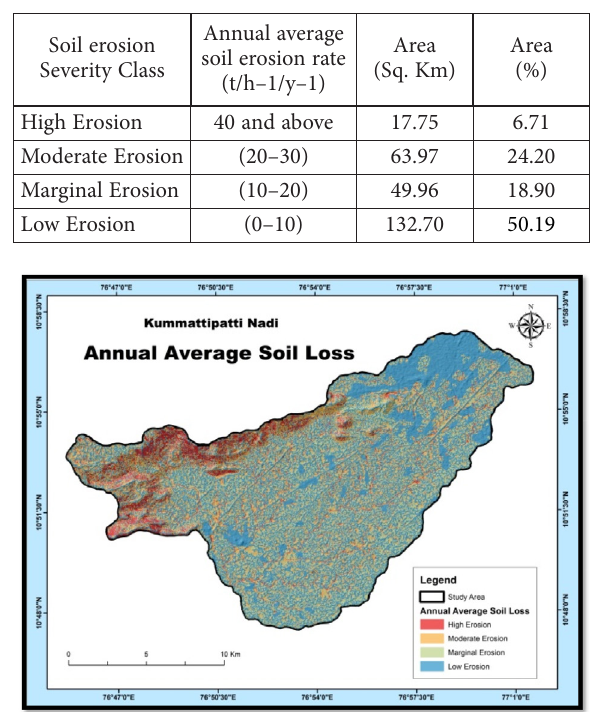
Figure 7. Supporting Conservation Practice factor (P)